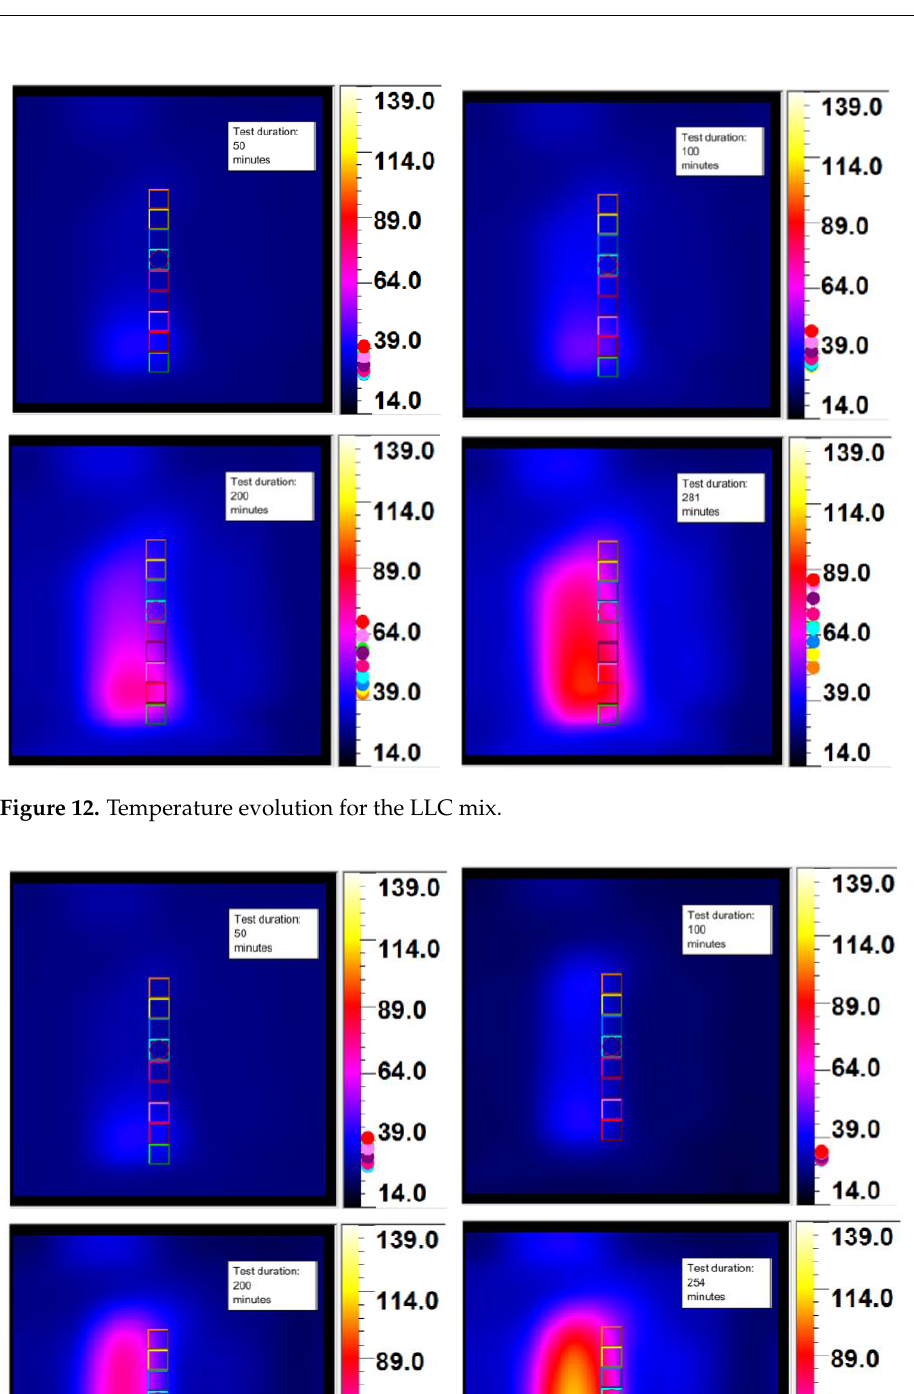
Figure 11. Post-test appearance of LLC ( top ) and SLC ( bottom ) mix specimens after cracking.